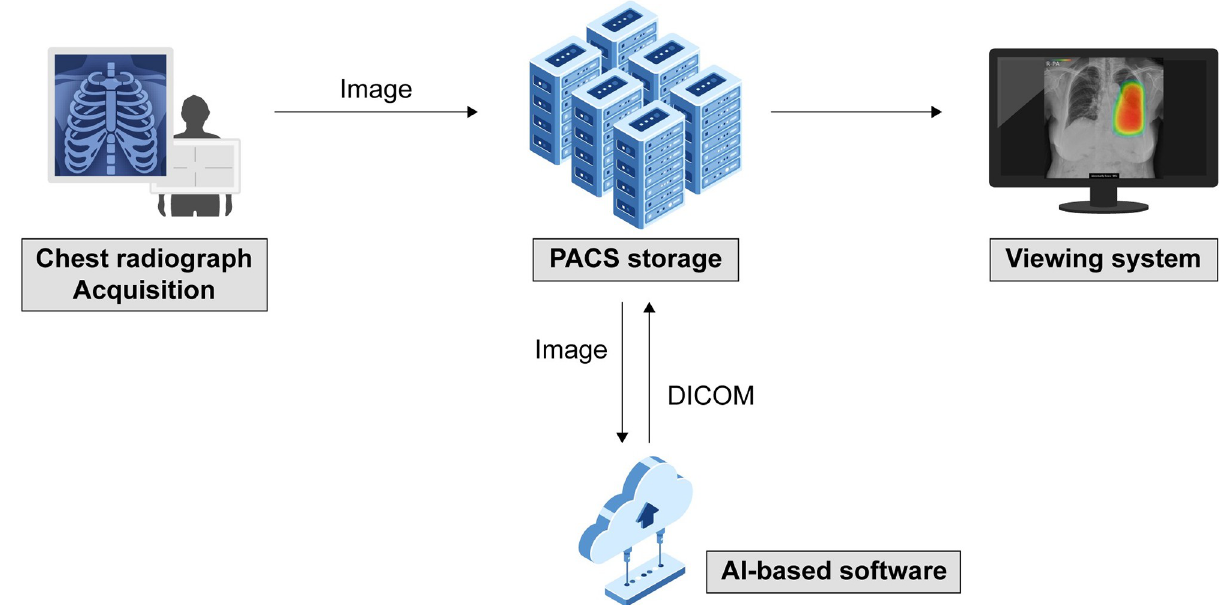
Fig 1. Integration of artificial intellingence results in the picture archiving and communicating system (PACS). For the included patients, we assessed the abnormality score of AI for the detected lesion in each chest radiograph. In addition, the interval between radiograph and consultation with a pulmonologist was evaluated. Whether the consultation with pulmonologists occurred before or after receiving the radiologists’ official report was assessed based on the reading time and consultation time recorded in the electronic medical records.